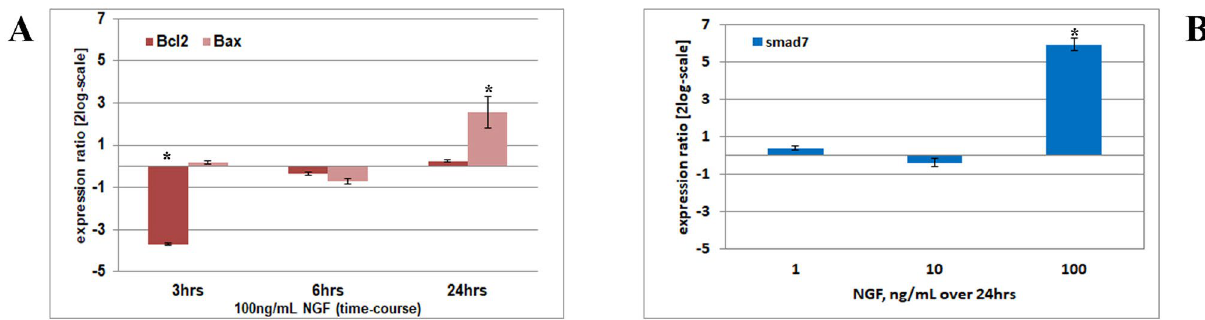
Figure 4. NGF and Bcl2/Bax associated apoptosis. NGF modulates Bcl2/Bax transcript ratio ( A ; time response) and Smad7 ( B ; dose response) transcript expression. Real time PCR followed by REST-ANOVA coupled analysis TGFβ1 signaling. Data are mean ± SEM (fold changes as log2-expression) of three independent